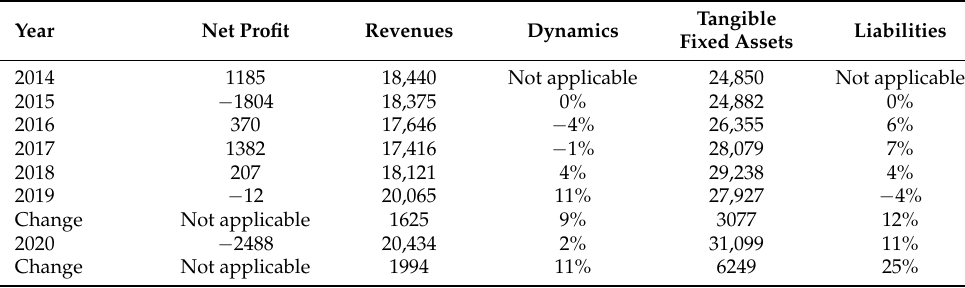
Table 6. Net profit, revenues and tangible fixed assets of Tauron Capital Group in 2014–2020 (in PLN